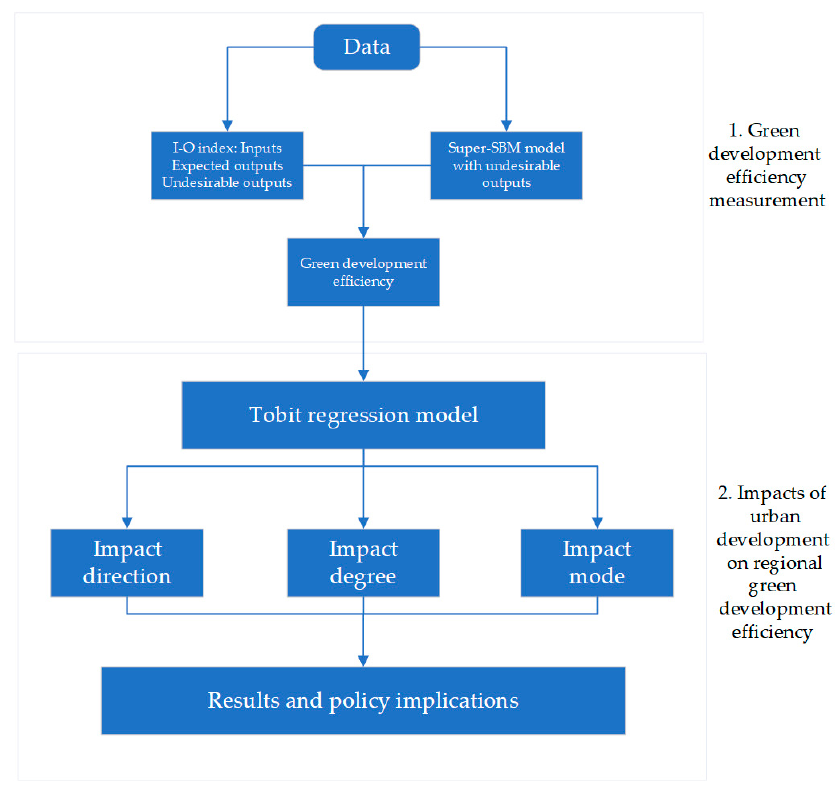
Figure 2. Exploration of the links of impacts of urban development on GDE. Note: the figure was made by the authors. made by the